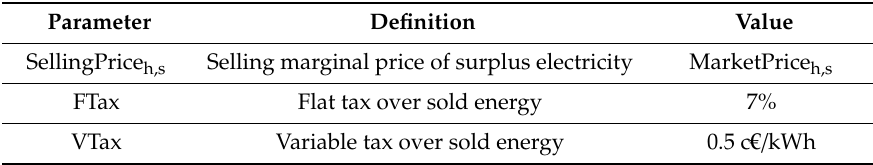
Table 7. Parameters related to the energy sale.